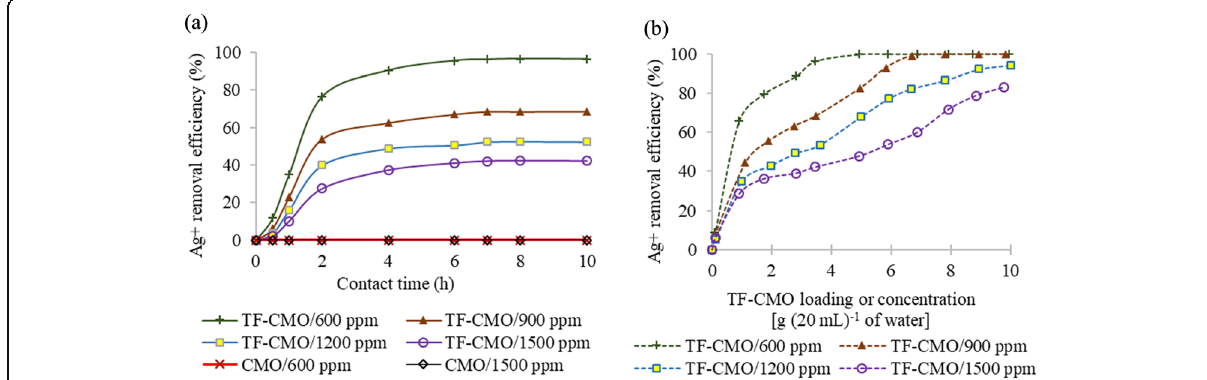
Fig. 6 Variation of sorption efficiency for water samples of different contamination levels, based on: a constant extractant dosage with varying contact time, b varying extractant dosage at common equilibrium contact